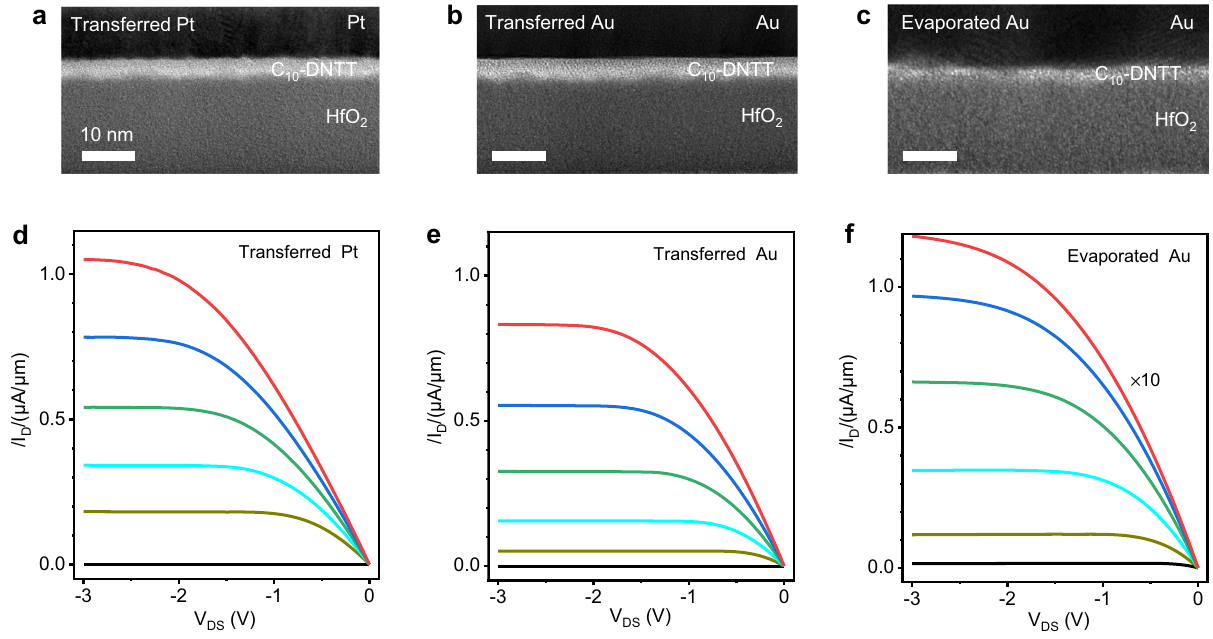
Fig. 1 | Characterizations of metal and organic semiconductor contact. Cross- sectional TEM image of metal/monolayer C 10 -DNTT/HfO 2 stacks by transferring Pt ( a ) and Au ( b ) electrode, and evaporating Au ( c ) electrode on top of C 10 -DNTT, respectively.Typicalroomtemperature I D ~ V DS characteristicsof transferred-Pt ( d ),